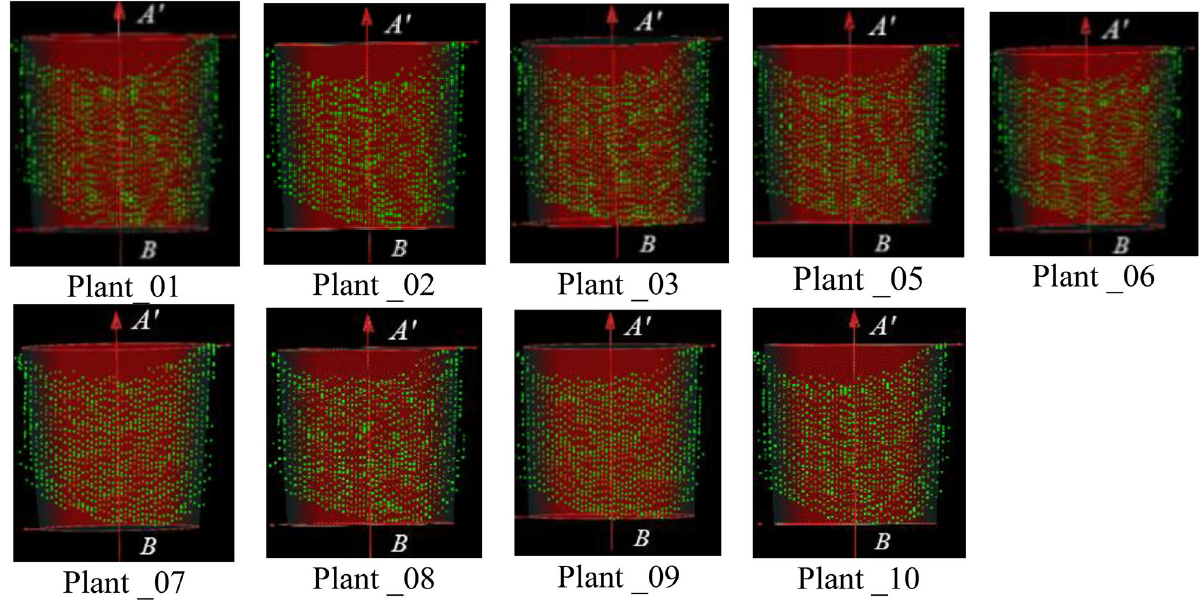
Figure 9. Effect diagrams of conical surface fitting of flowerpot wall.